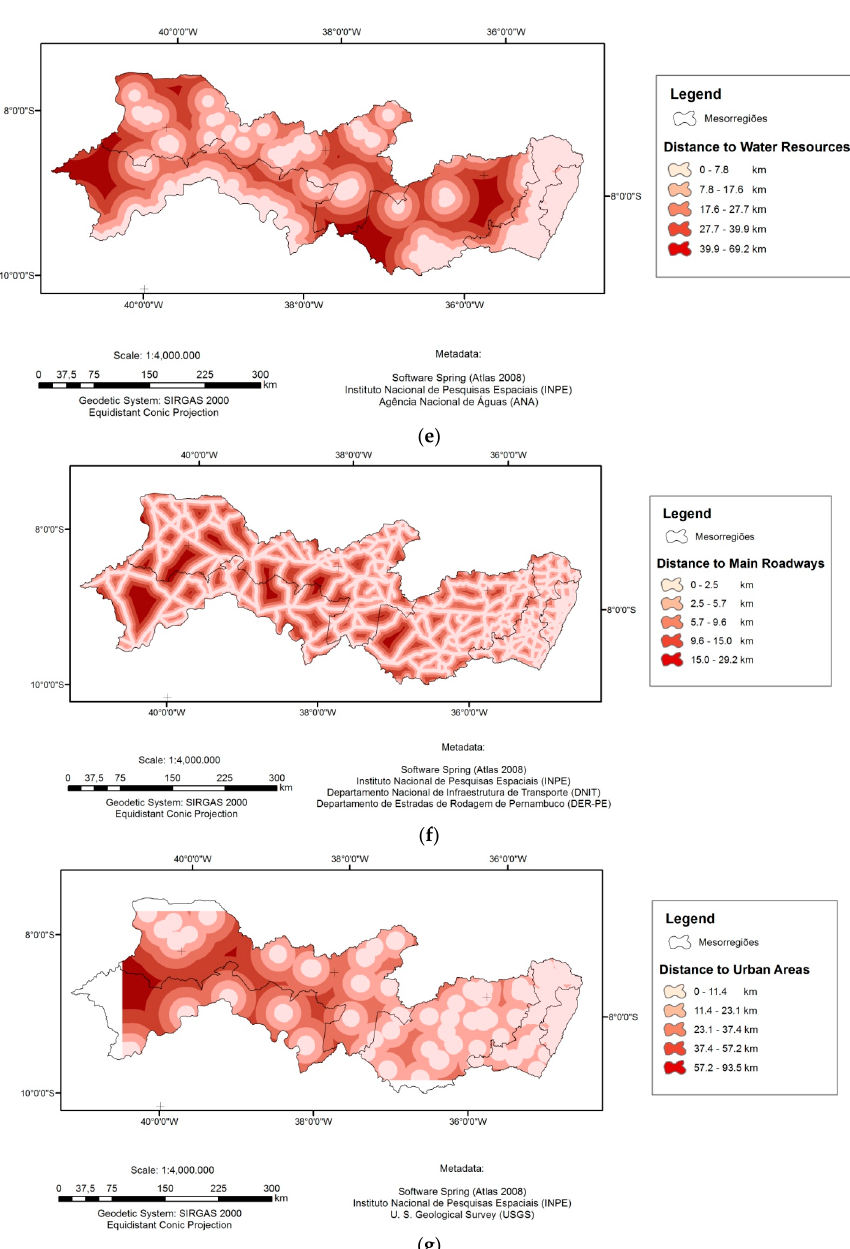
Figure 8. ( a ) Map of the Direct Solar Irradiation; ( b ) Map of Terrain Slopes; ( c ) Map of Agricultural Potential of the Soils; ( d ) Map of the Distances to Power Lines; ( e ) Map of the Distances to Water Resources; ( f ) Map of the Distances to Main Roadways; ( g ) Map of the Distances to Urban Areas.